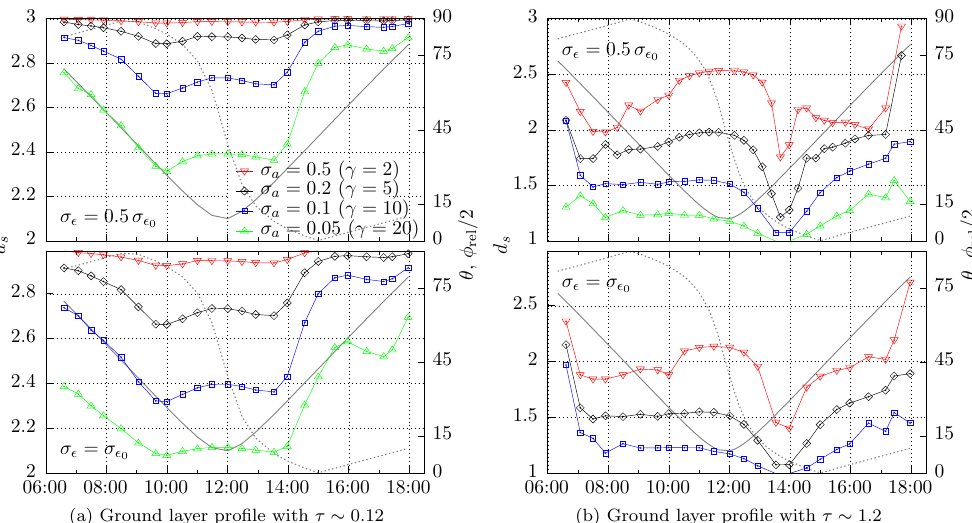
Fig. 8. Degrees of freedom of the signal d s =tr( A ) for the regularised least-squares retrieval, Eq. (11), of x =( k L · 1km, τ L , τ E ) T for the ground layer profiles with (a) τ ∼ 0.12 and (b) τ ∼ 1.2 (see Fig. 2) for different levels of regularisation and levels of measurement noise (viewing direction west).